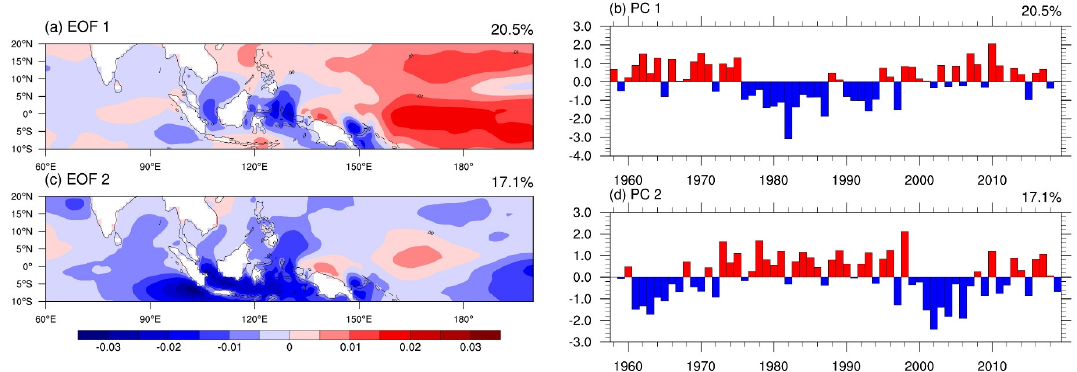
Figure 10. ( a , b ) The first and second mode of the empirical orthogonal function (EOF) of the detrended SLHF in the IPWP. ( c , d ) The standardized time series of the PC1 and PC2, respectively.